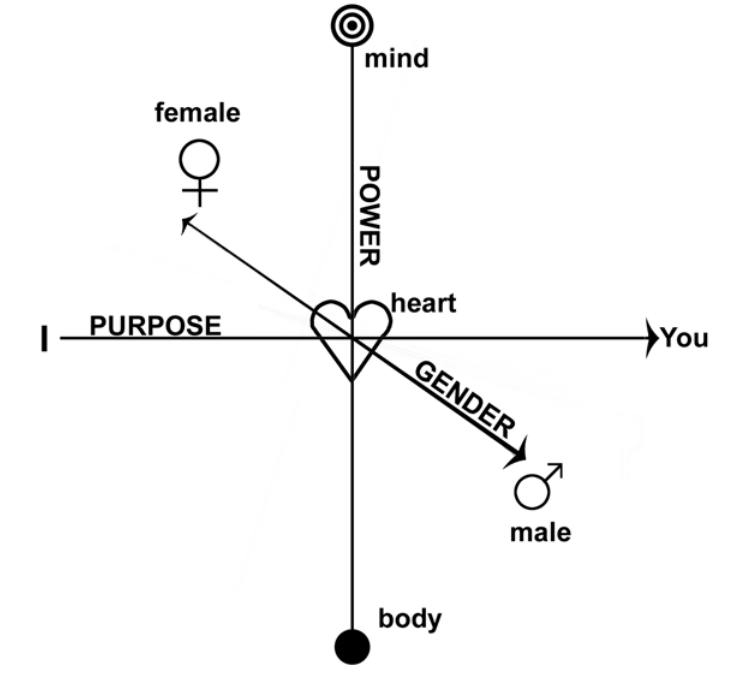
FIGURE 1 . A human being exists in three dimensions, and all of them must be in their natural state to allow the full expression of talent. The saggital axis is called purpose or love or I-you , the vertical axis is called power or consciousness (light) or heaven-earth , and the horizontal axis is called gender or joy or male-female